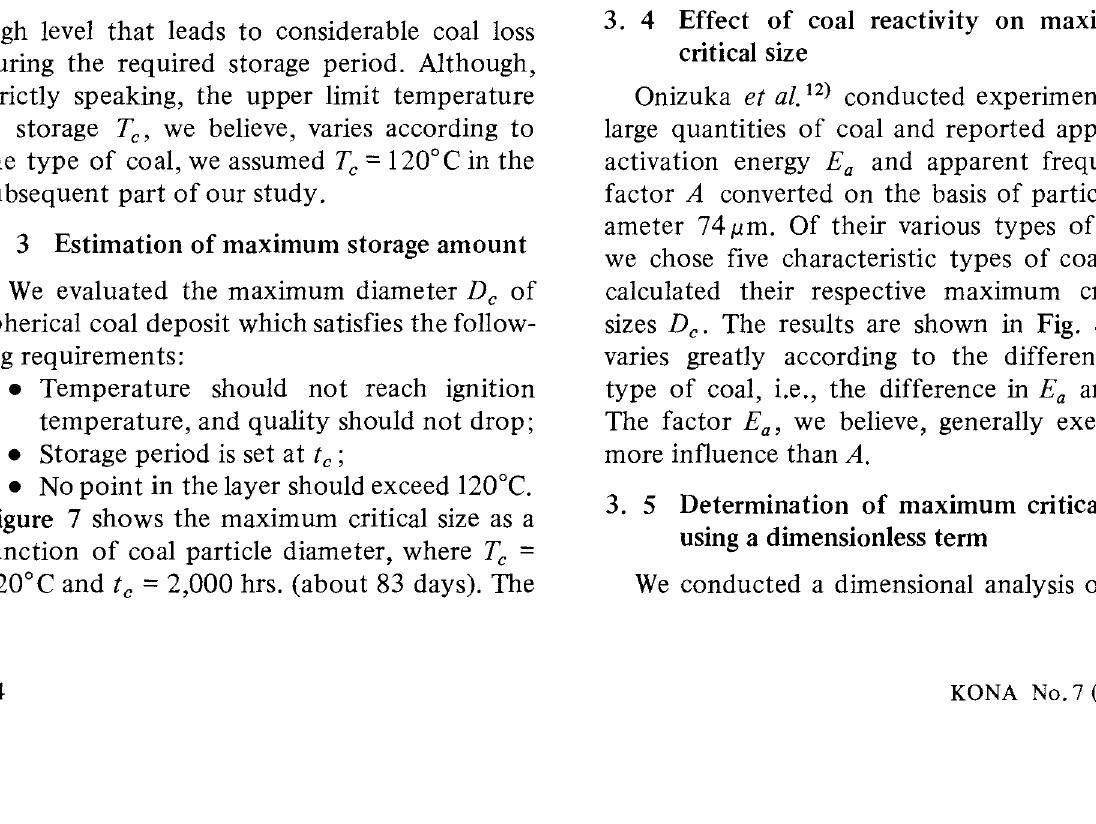
Fig. 8 Effect of coal reactivity on a maximum critical size in coal storage